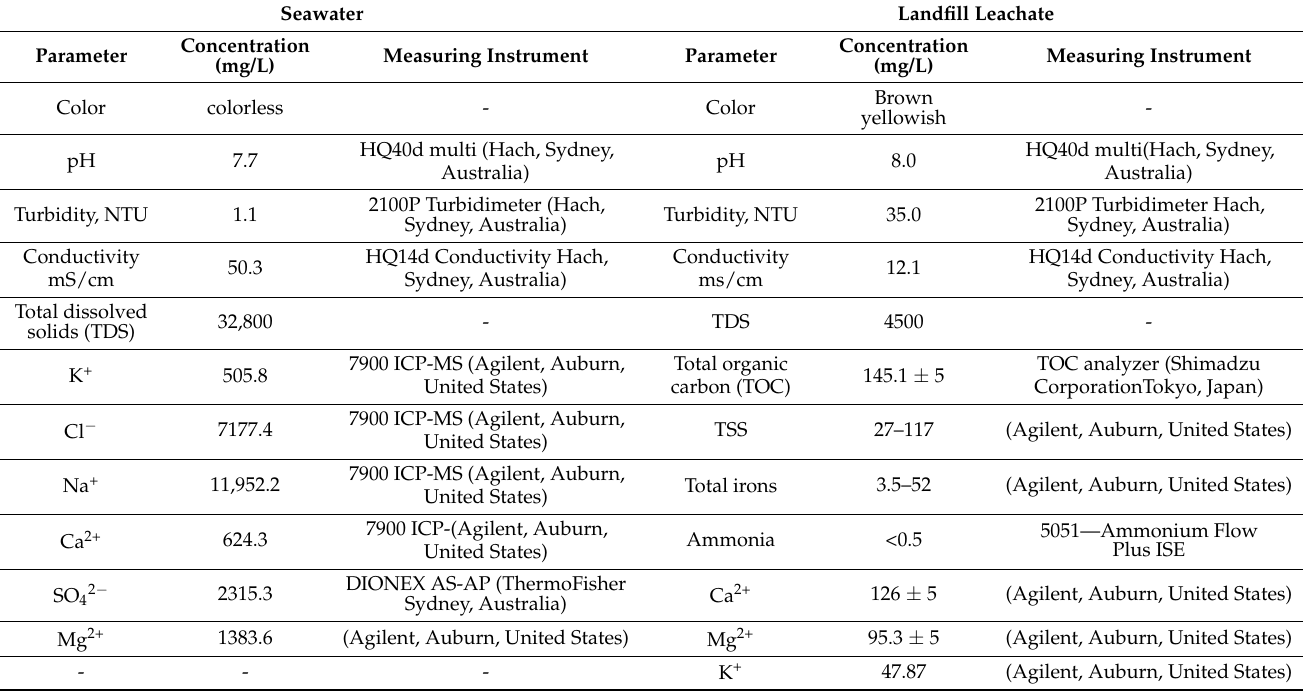
Table 1. Characteristics of the seawater and landfill leachate.